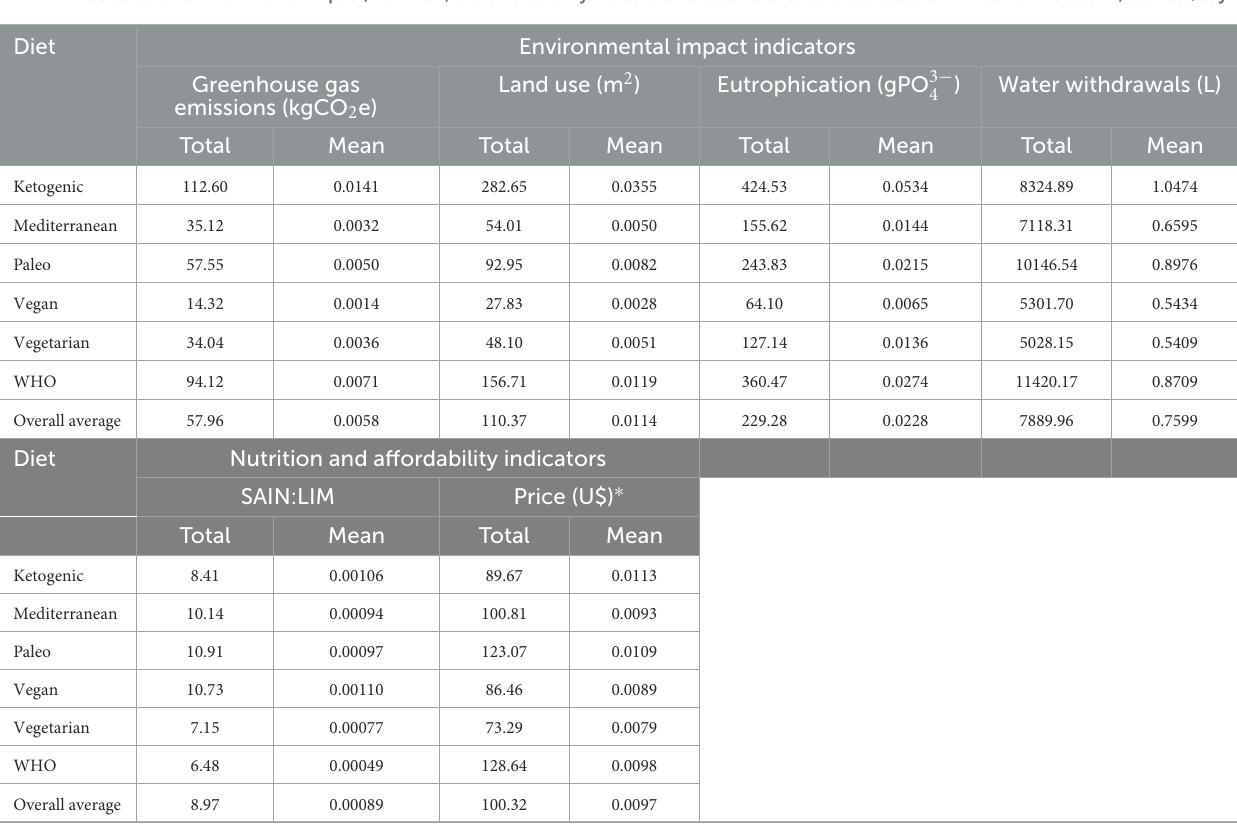
TABLE 4 Measures for environmental impact, nutrition, and affordability indicators for each diet calculated based on 1 week of meals at 2,000 kcal/day.